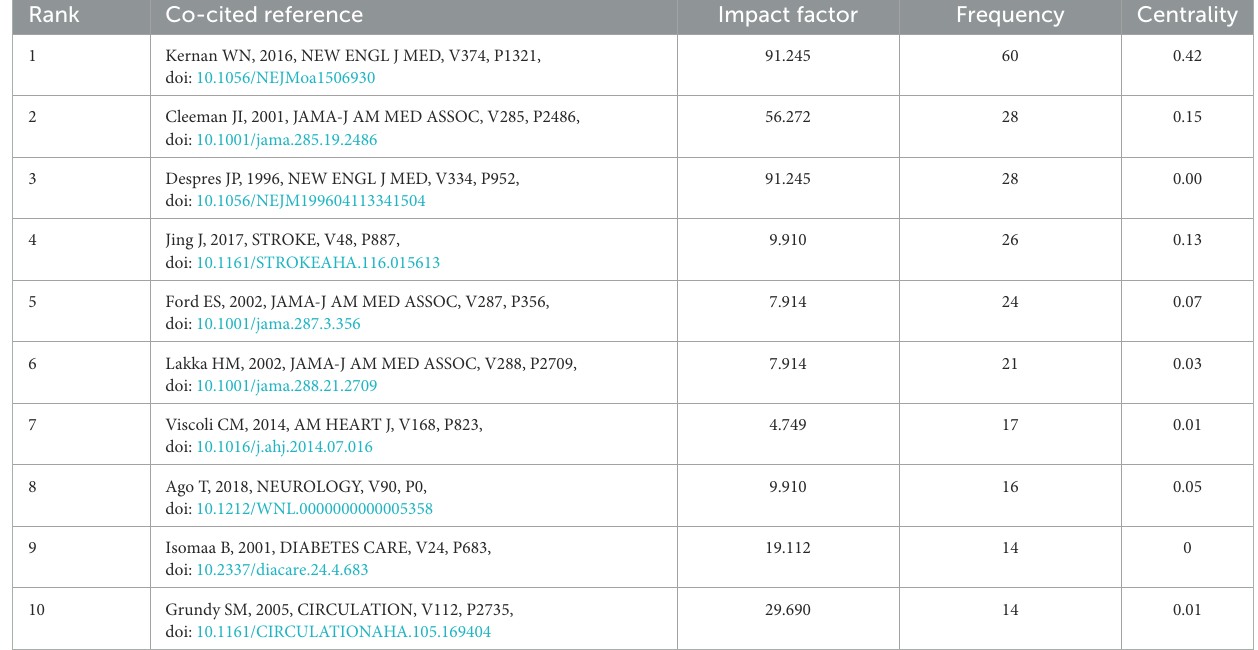
TABLE 3 Top 10 co-cited references with the highest frequency on insulin resistance and ischemic cerebrovascular disease. Rank Co-cited reference Impact factor Frequency